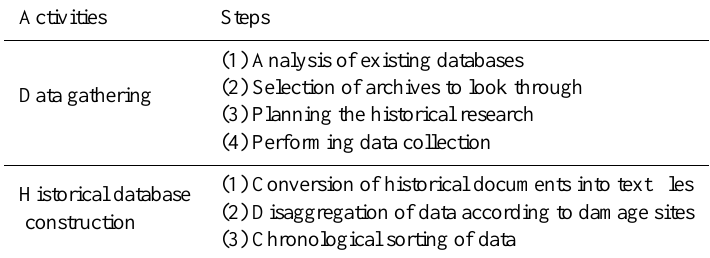
Table 5. Main steps in the creation of local flood databases (Polemio and Petrucci, 2012).